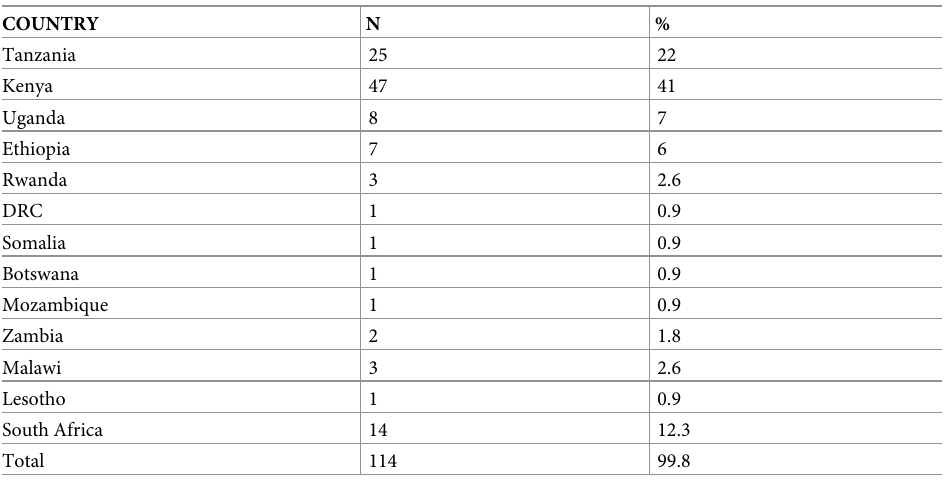
Table 2. Distribution of respondents by study